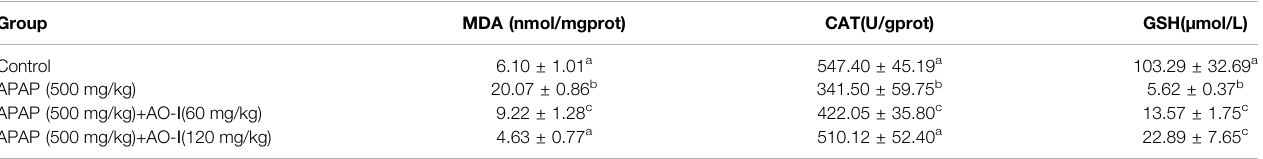
TABLE 2 | AO-I ameliorates APAP-induced oxidative injury.